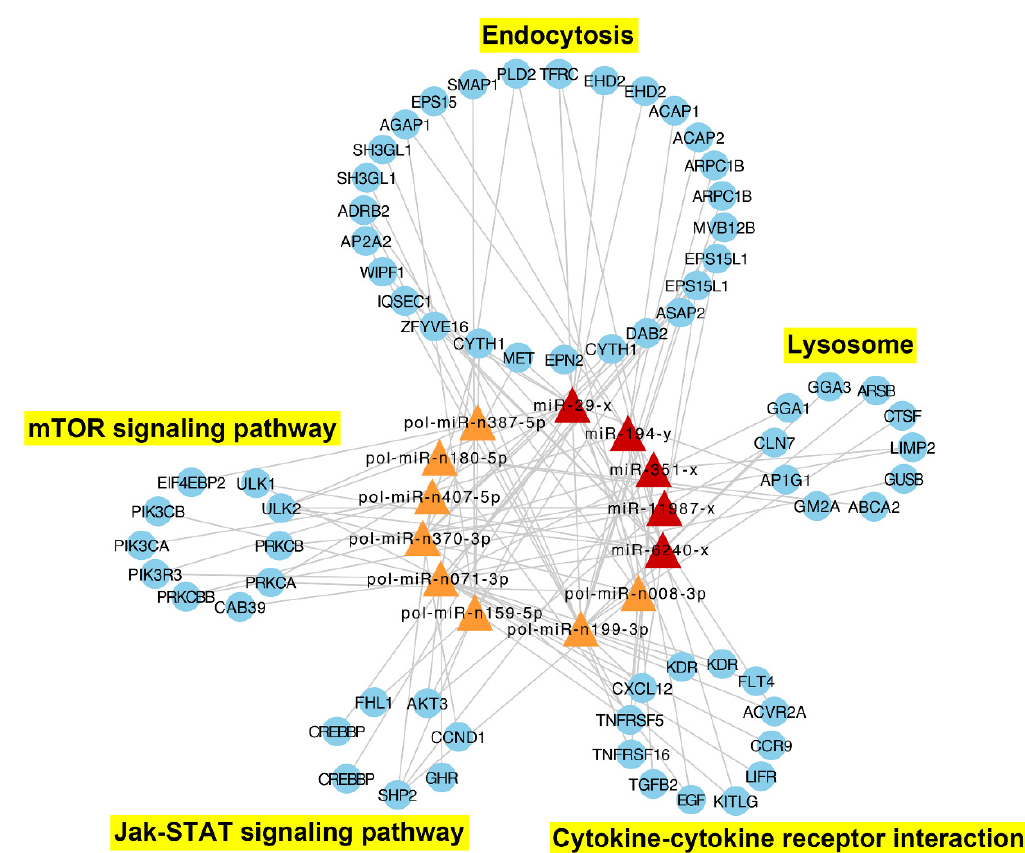
Figure 5. The immune-related network formed by interactive DEmiRs (differentially expressed miRNAs) and DETGs (differentially expressed target genes of the DEmiRs). The blue round nodes indicate immune-related targeted DETGs; the triangle nodes indicate DEmiRs, of which the known miRNAs are in red and the novel miRNAs are in orange. The pathways to which the DETGs are enriched are indicated and marked in yellow.